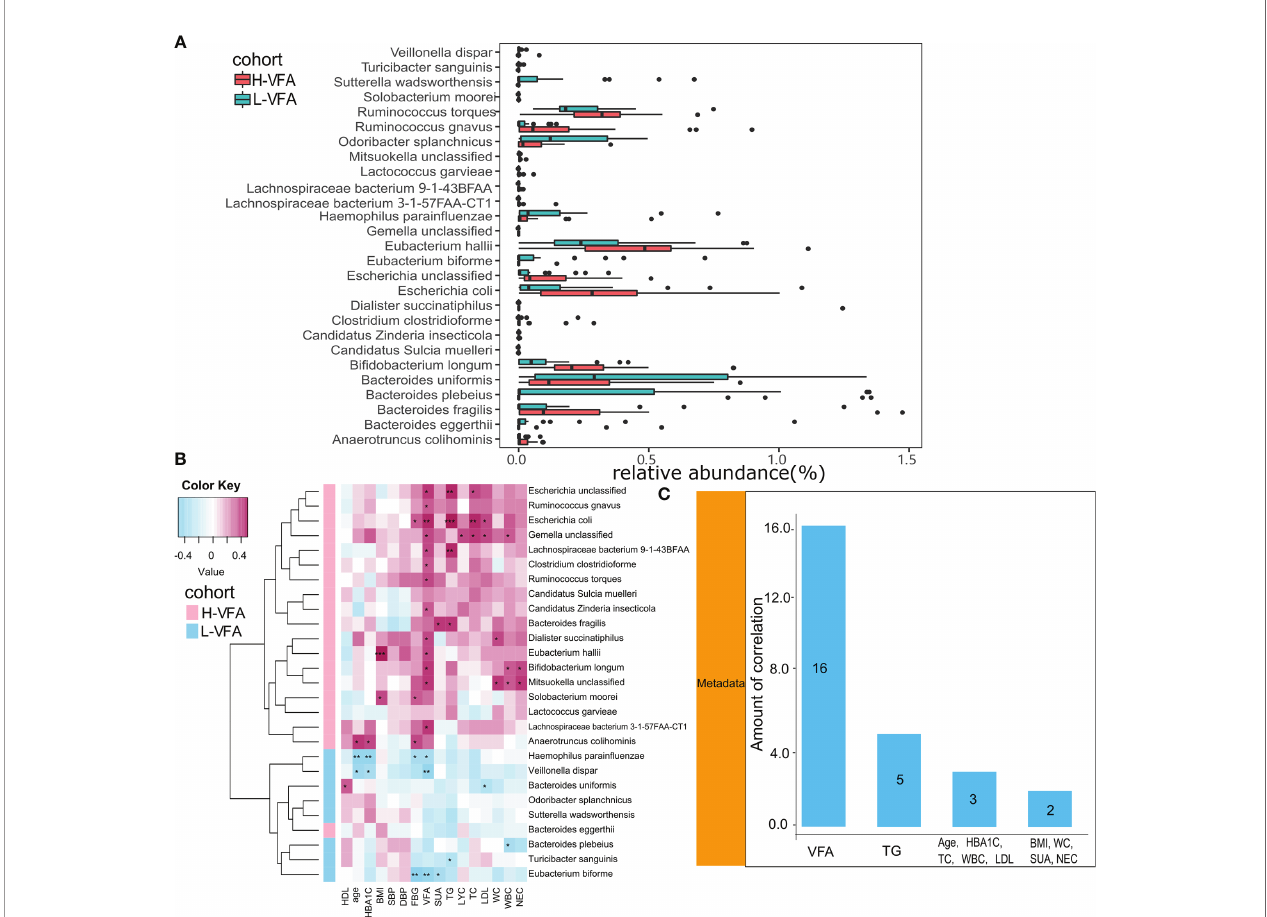
FIGURE 2 | (A) The relative abundance of bacterial species between the H-VFA group and the L-VFA group. Wilcoxon test analysis of the relative abundance of bacterial species showed signi fi cant differences in 27 species, with nine species enriched in the L-VFA group and 18 enriched in the H-VFA group. (B ) Correlations between bacteria and clinical characteristics. Pink cells denote positive correlations, whereas blue cells depict negative correlations. *, **, and *** denote p < 0.05, p < 0.01, and p < 0.001, respectively. (C) The number of signi fi cant correlations for the eleven risk